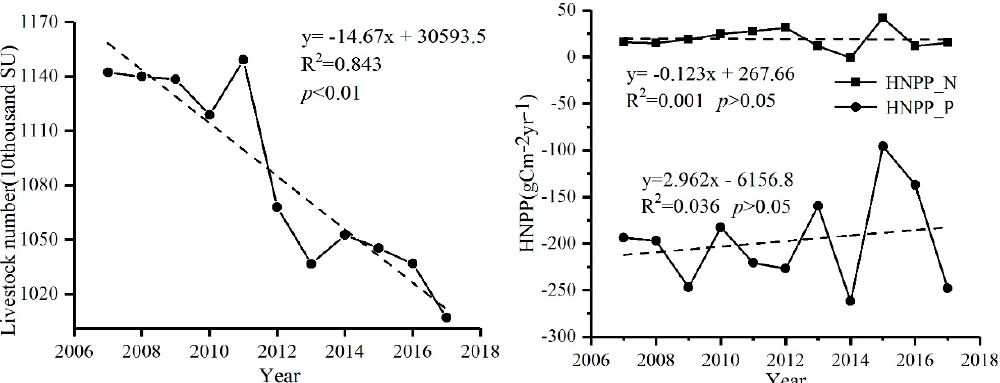
Figure 17. Interannual changes in stocking capacity and HNPP multi-year average in Three-River Source Region from 2007 to 2017.